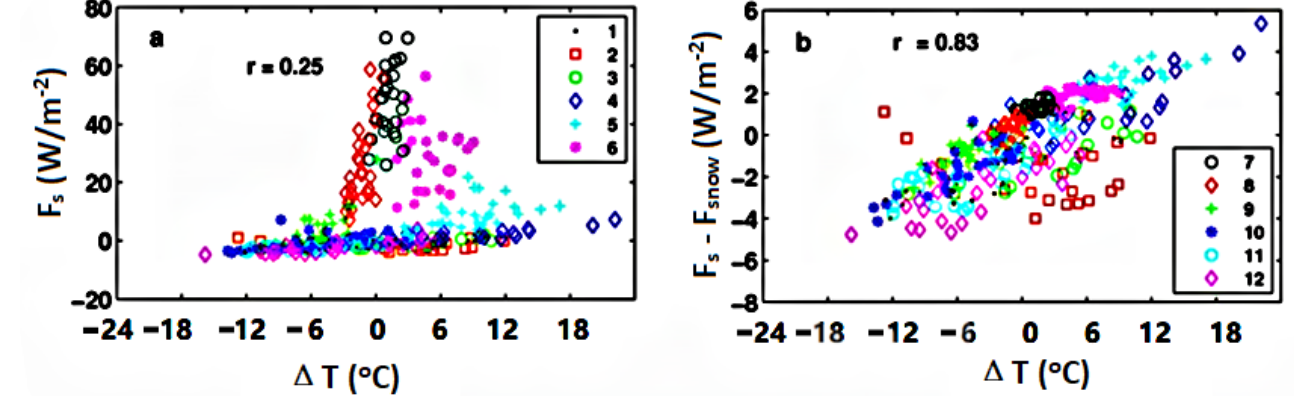
Figure 5. ( a ) Scatter plot between the net surface energy flux F s and surface temperature change Δ T at a land location for each month (1–12 means JAN-DEC). ( b ) Scatter plot between F s − F snow and surface temperature change Δ T. F s (W/m − 2 ) F s − F snow (W/m − 2 ) Δ T ( o C)